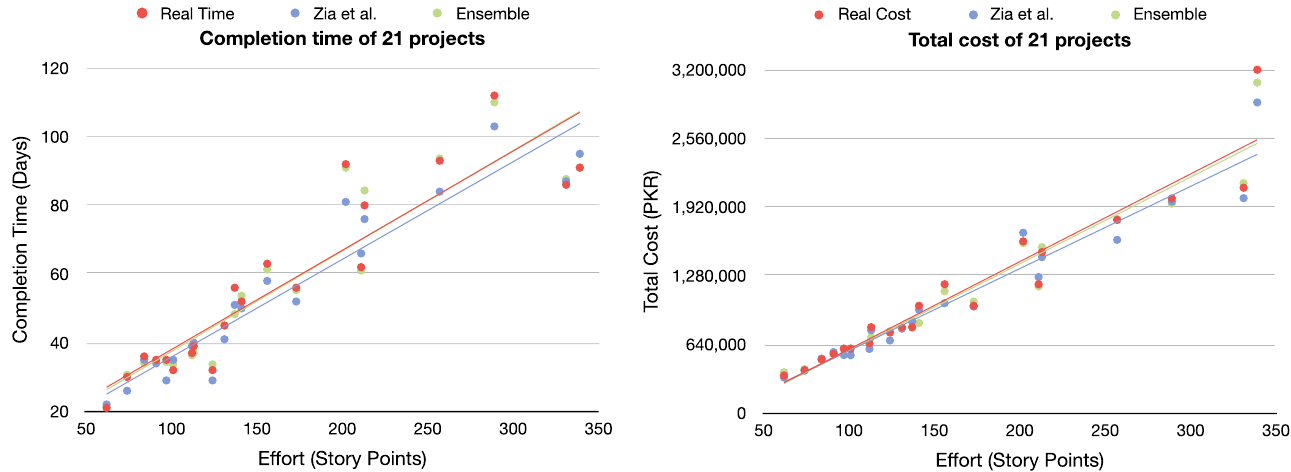
Figure 11. Predictions plotted with their regression lines, with Zia et al. [31] in blue and bagging ensemble in green.